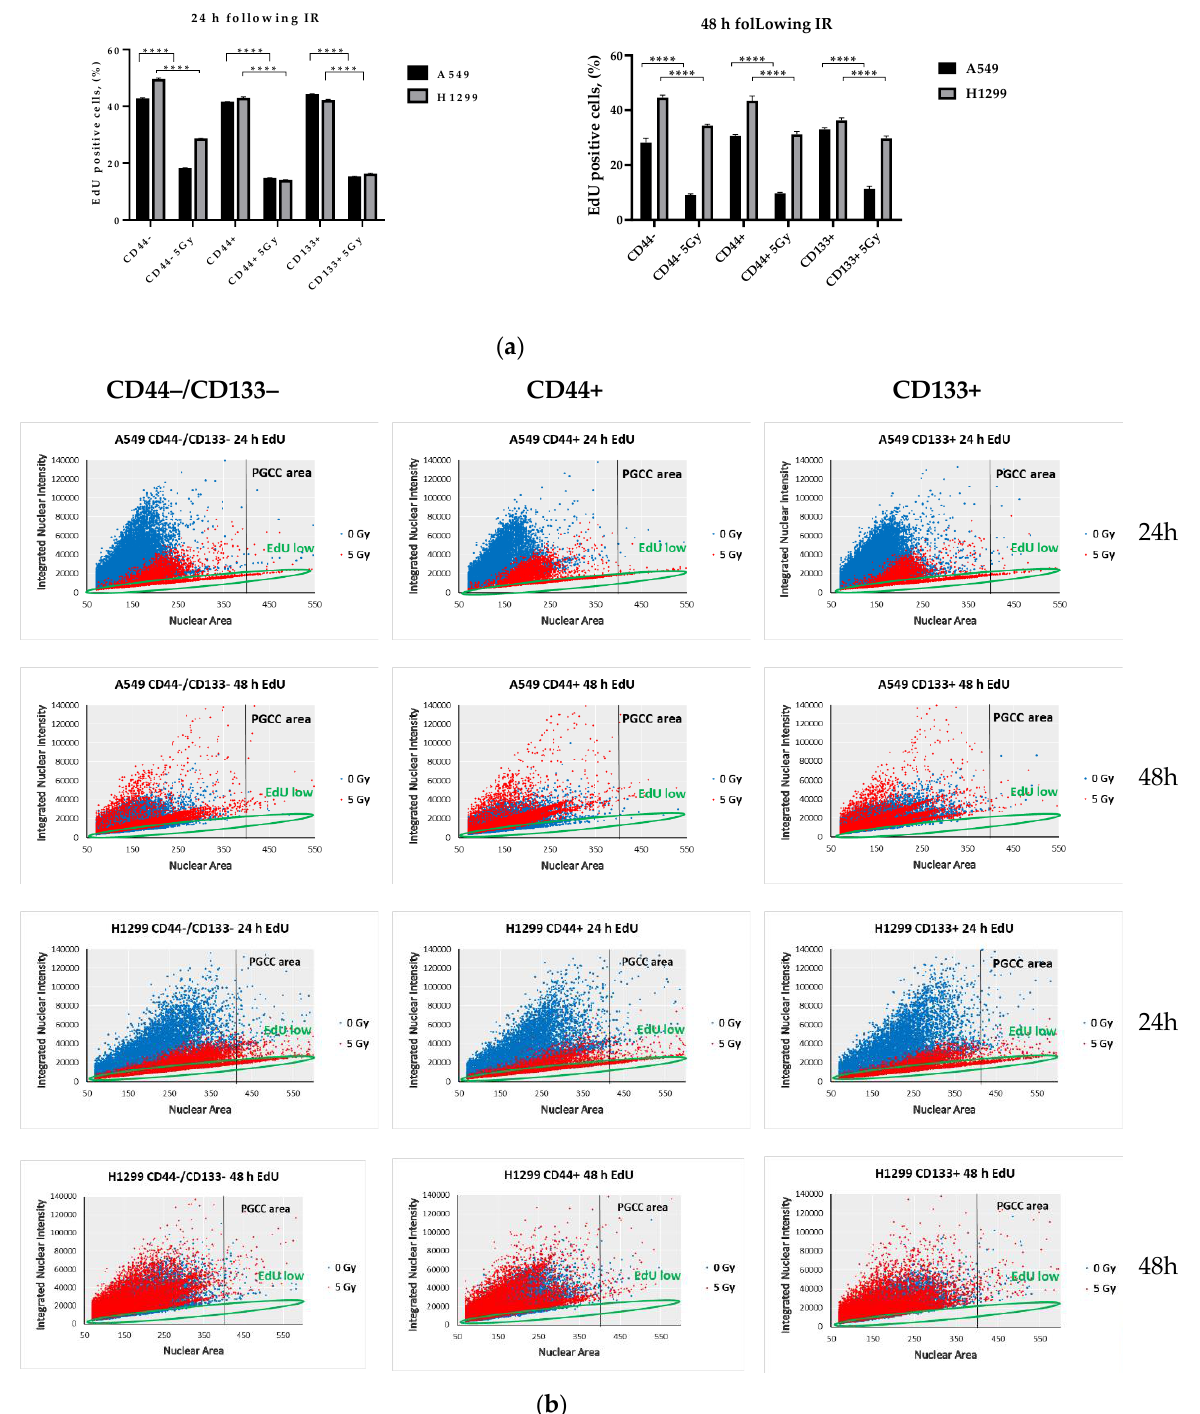
Figure 6. EdU-coupled fluorescence-intensity analysis of distinct cell-cycle characteristics. ( a ) The proportion of EdU-positive cells in CD-sorted populations of NSCLC cells 24 – 48 h after irradiation. ( b ) Using the ImageXpress Micro XL High-Content Screening System, we analyzed EdU fluorescence in PGCC 24 – 48 h after 0 Gy (blue dots) or 5 Gy (red dots) exposure The nuclear area of 400 nm was used as a threshold for PGCC cells according to the literature. Green circles demonstrate EdU low area of “quiescent” cells. Data are means ± SD of three independent experiments. Statistical significance is denoted by asterisks, where: **** p <